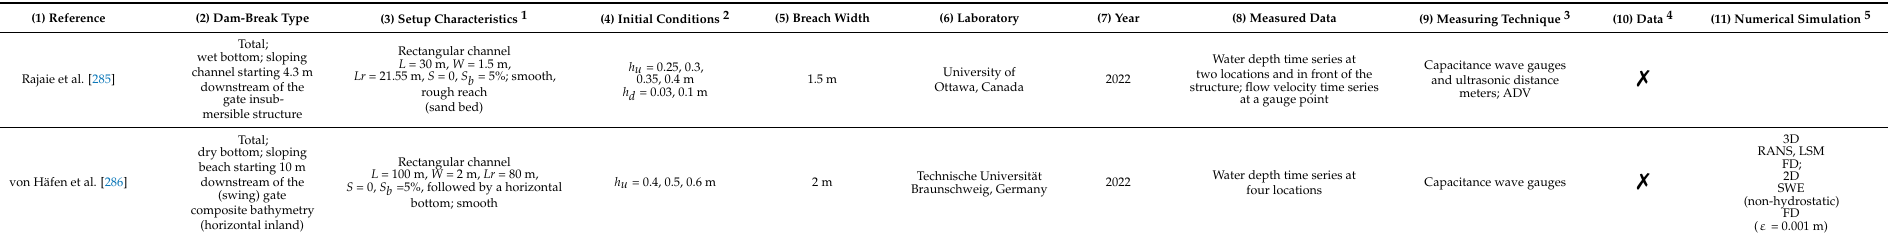
Table 1. Basic experimental investigations of fundamental dam-break wave physical characteristics.